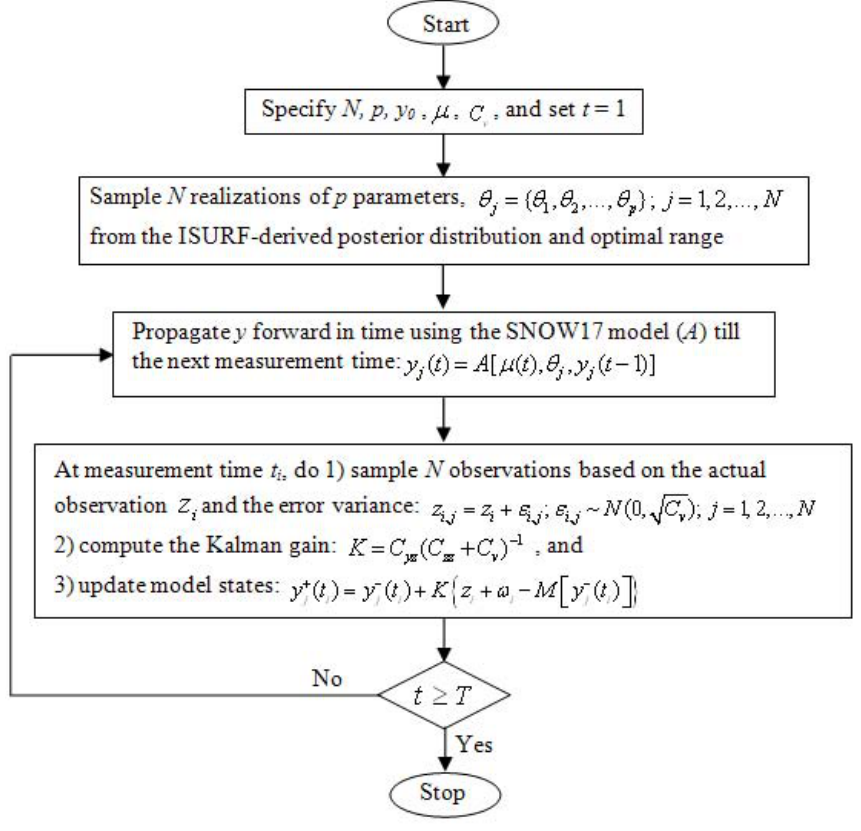
Fig. 3. Flowchart of the EnKF applied in ICEA to recursively update SNOW17 model states with the uncertainty of sensitive model parameters considered. N and p indicate the ensemble size and the number of sensitive parameters, respectively; y 0 and µ represent model initial condition and forcing, respectively; z i and M designate the observation and measurement operator, respectively; C v , C yz , and C zz denote the variance of observation error, the covariance between model states and observations, and the variance of observations,